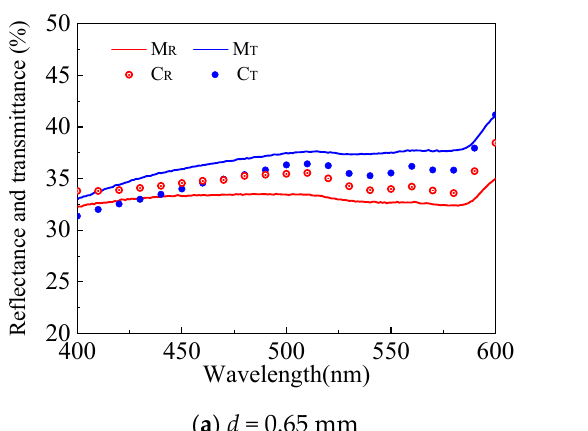
( b ) reflectance spectrum Figure 14. Beam spot-affected spectral signal. With the optimal spot size, the reflectance and transmittance in the blood vessel-em-